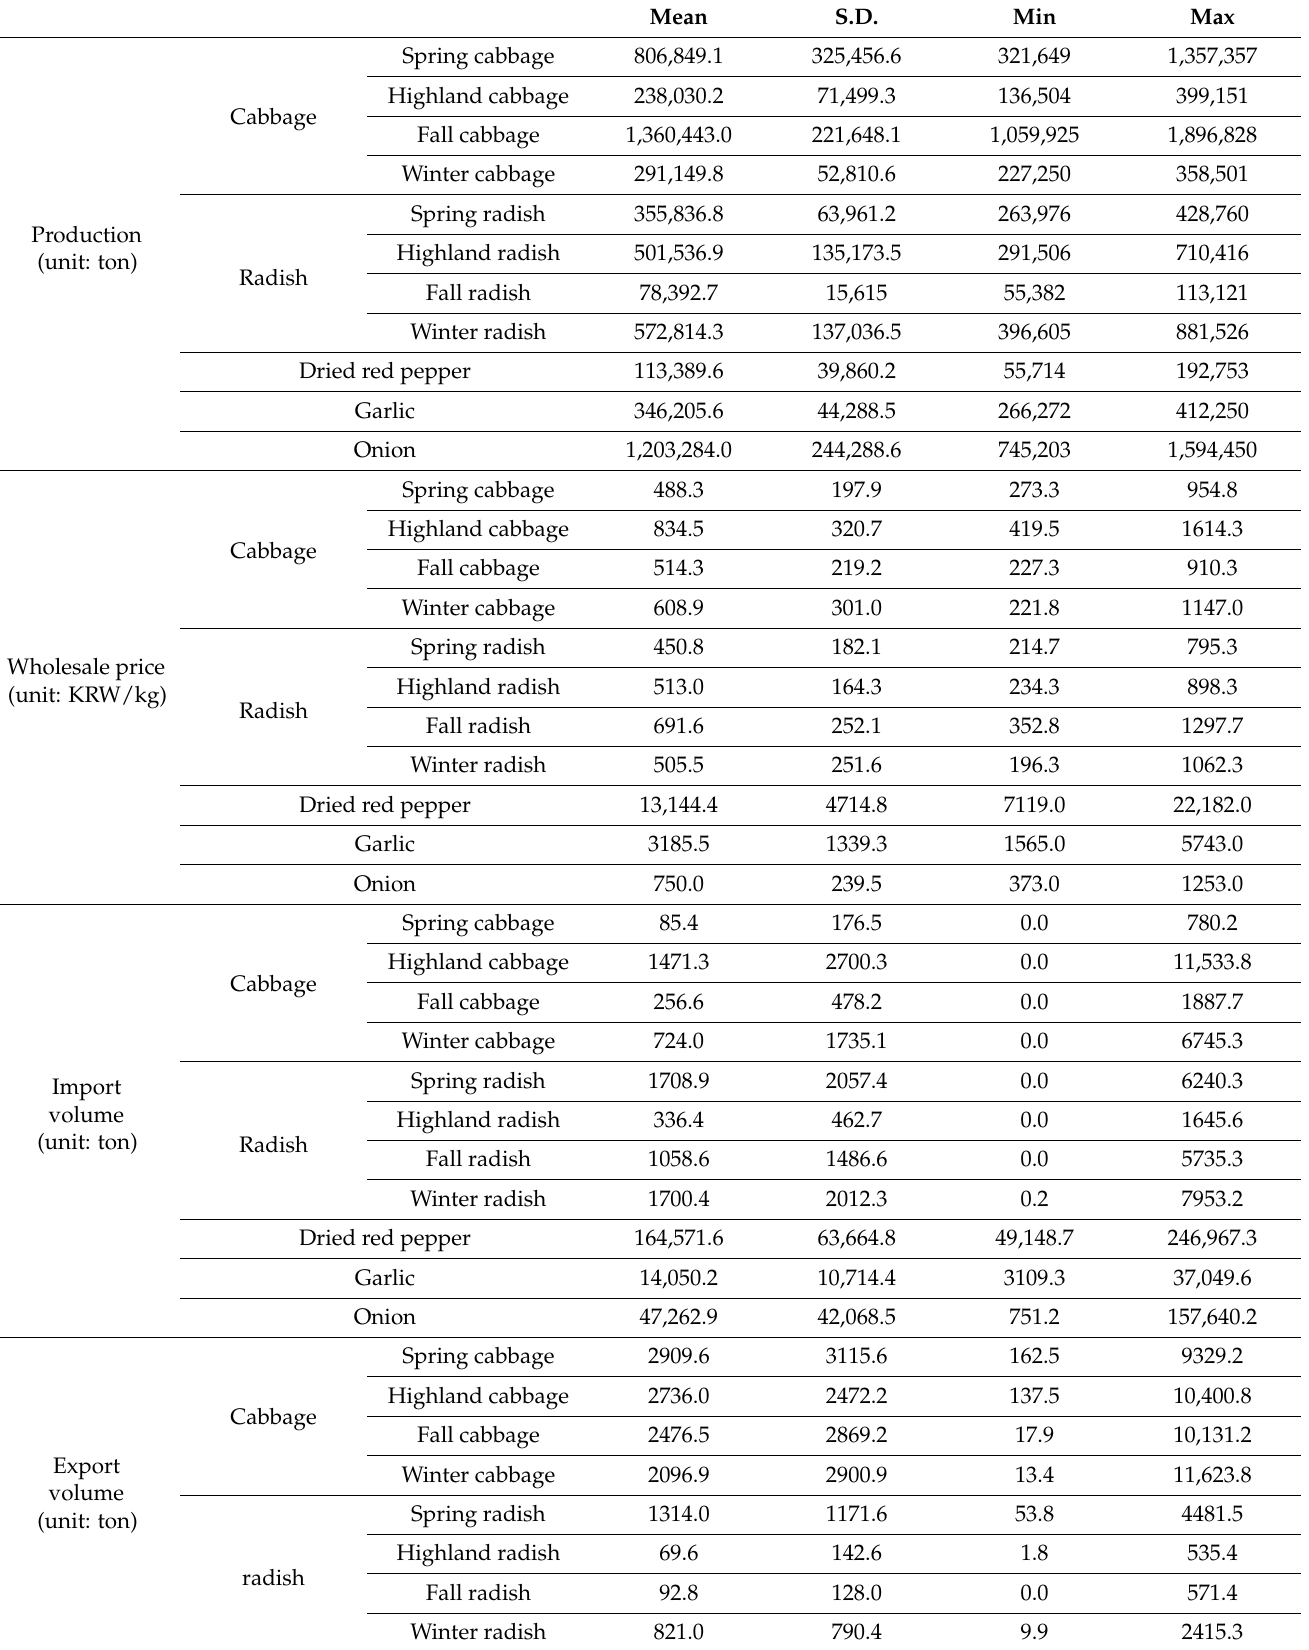
Table 2. Descriptive statistics of the